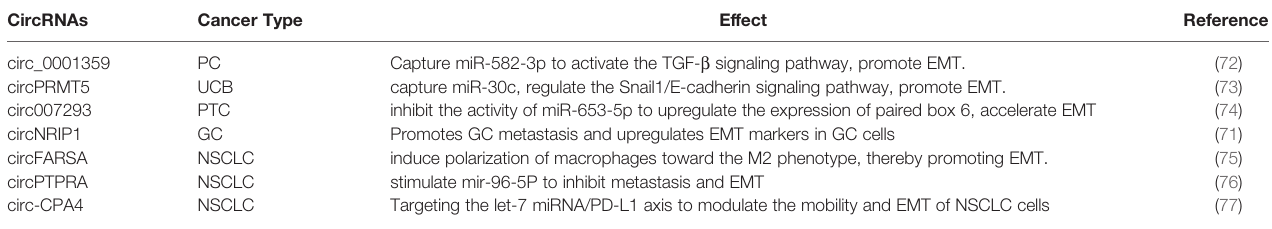
TABLE 4 | The effects of circRNAs carried by exosomes on EMT.